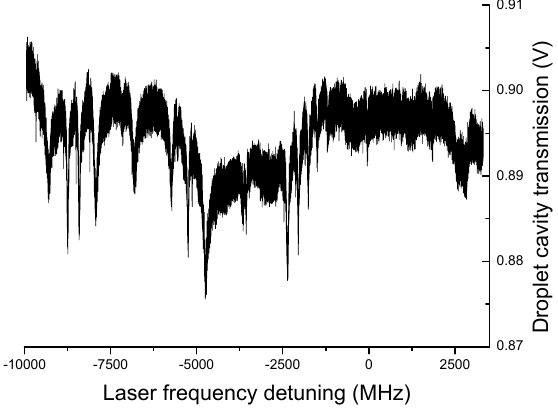
Figure 9. WGMs recorded on the transmission of a pure H 2 O droplet using a laser at 475 nm.